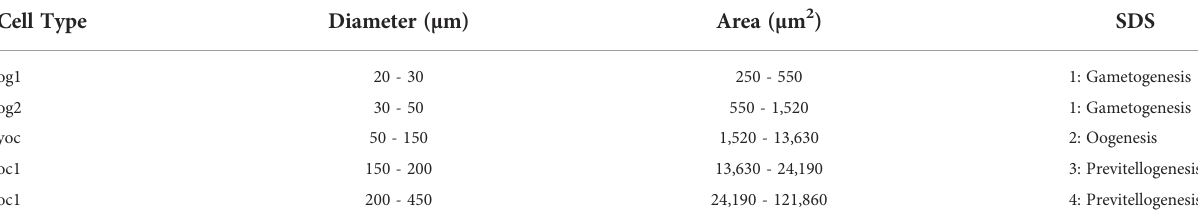
TABLE 1 Ovarian cell types with corresponding cell diameters (µm) as determined by Cuzin-Roudy and Amsler (1991) and cell areas (µm 2 ) measured in this study. Cell